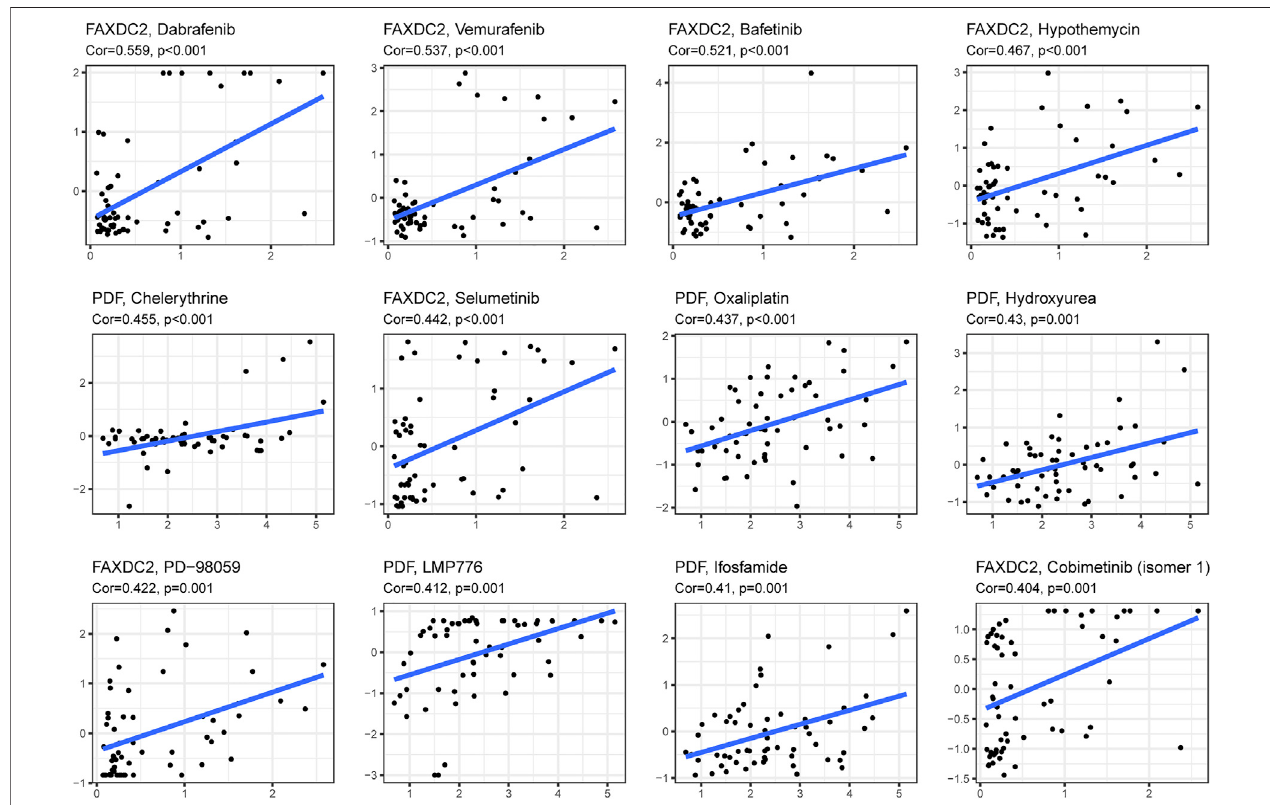
FIGURE 8 | Candidate drugs targeting the fi ve RNAs. The top 12 drugs targeting the fi ve genes ranked by correlation tested by Pearson correlation analysis.